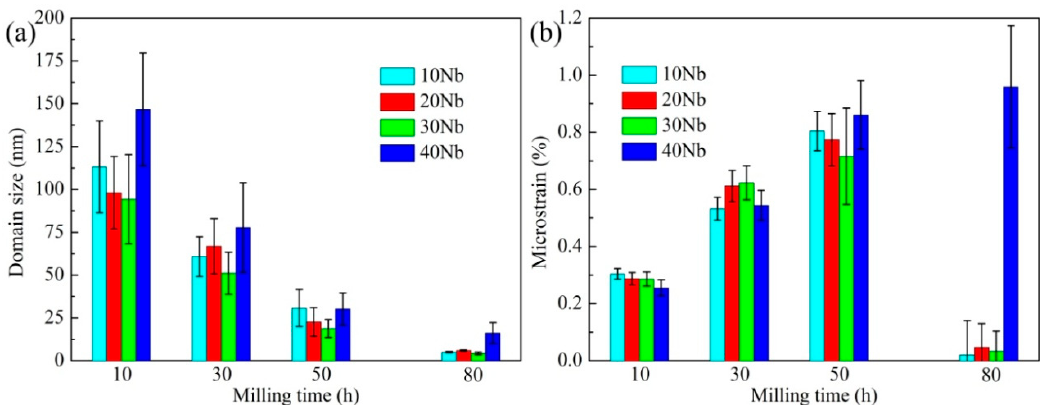
Figure 4. Evolutions of ( a )domain size and ( b )microstrain of Moss as a function of milling time for 10Nb, 20Nb, 30Nb, and 40Nb powders. The vertical lines are error bars.